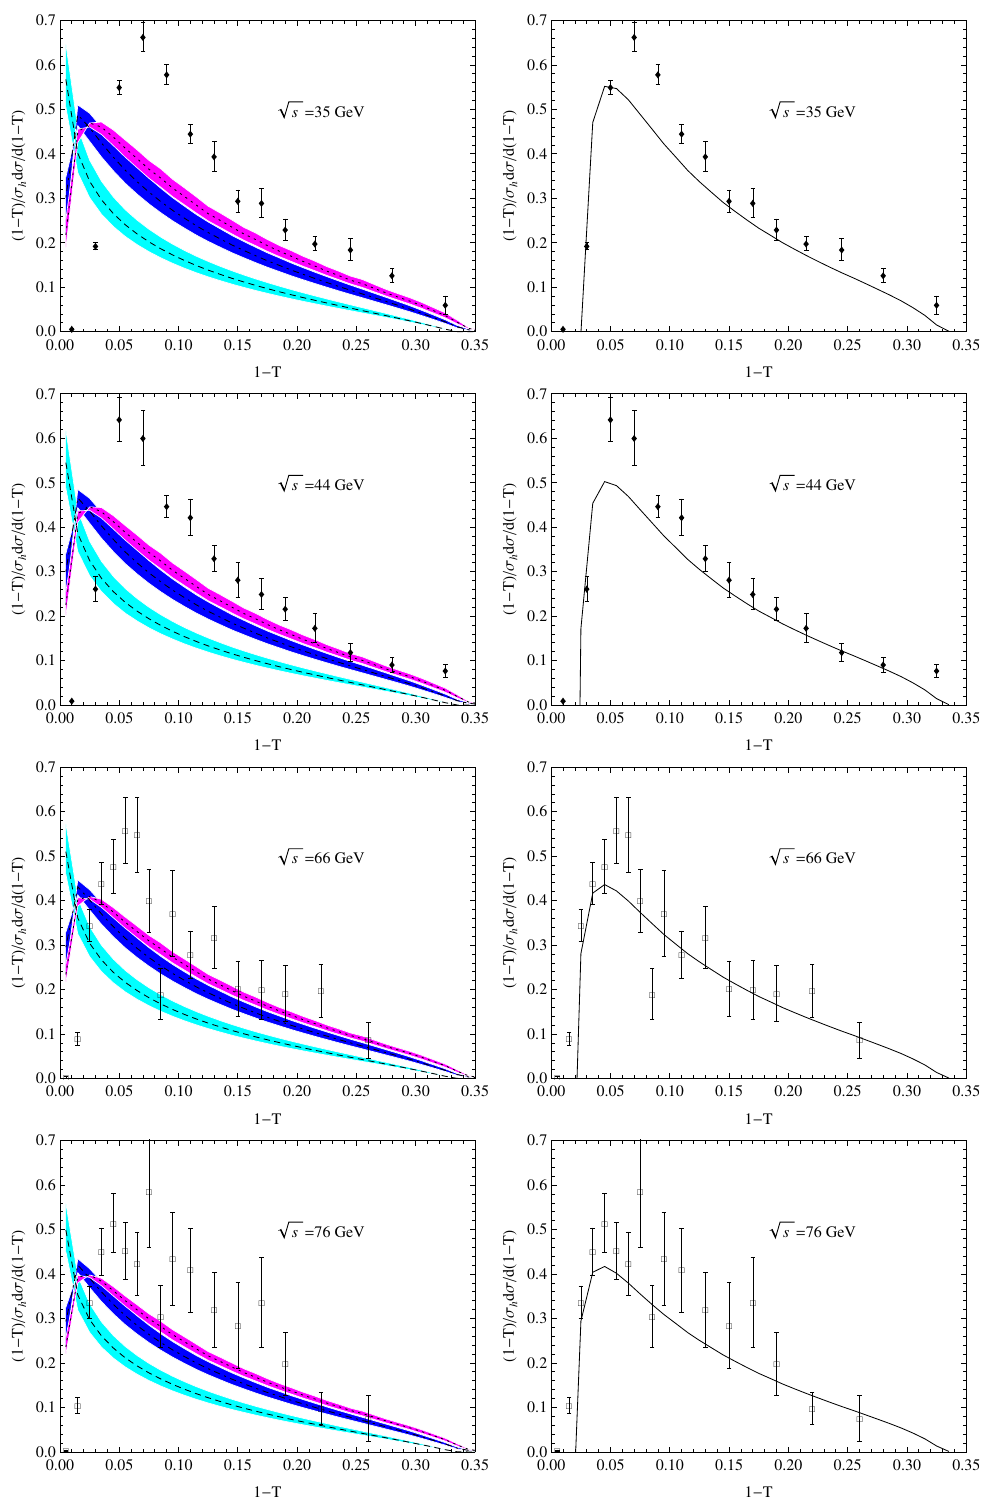
Figure 10. The thrust ( 1 − T ) distributions using conventional (left column) and PMC (right column) √ scale-settings for s = 35 , 44 , 66 , 76 GeV. The experimental data for √ from the JADE [56, 57], and s = 66 , 76 GeV data are taken from the DELPHI [2]